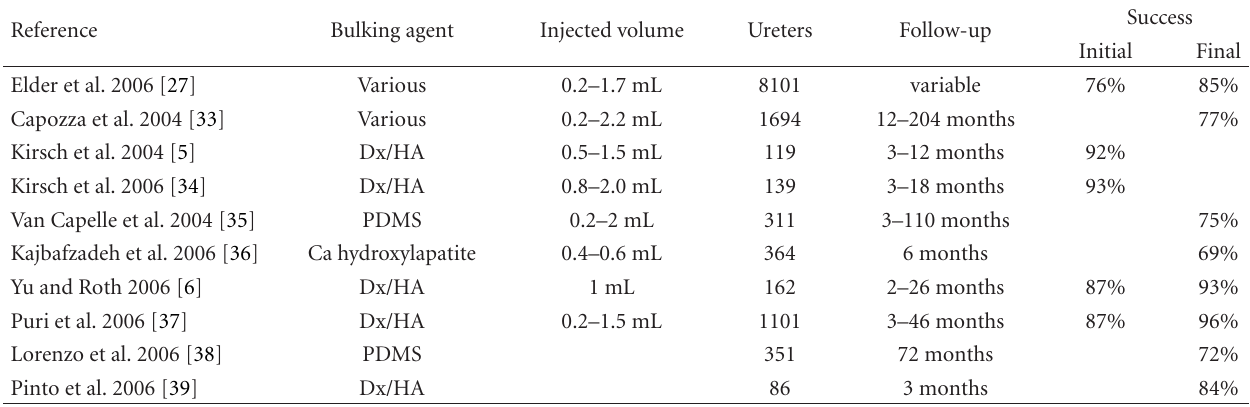
Table 1: Success rates of endoscopic treatment for primary VUR. Meta-analysis by Elder JS et al. 2006 summarizes results until 2003. More recent series are listed below. Initial success after one treatment and final success after two or more treatments.